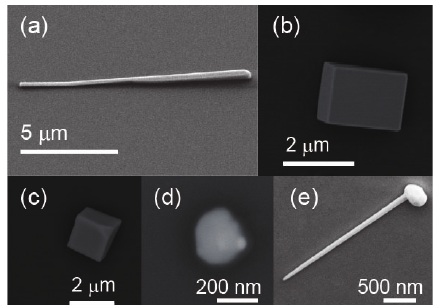
Figure 1. Scanning electron microscope topography of In-SnTe nanostructures grown ( a , b ) without gold nanoparticles (GNP), ( c , d ) with the use of 50-nm GNPs, and ( e ) with the use of 20-nm GNPs on a silicon substrate by the very similar VTG method reported in [26]. Scale bar for ( a ), ( b , c ), ( d ), and ( e ) are 5 µ m, 2 µ m, 200 nm, and 500 nm, respectively.